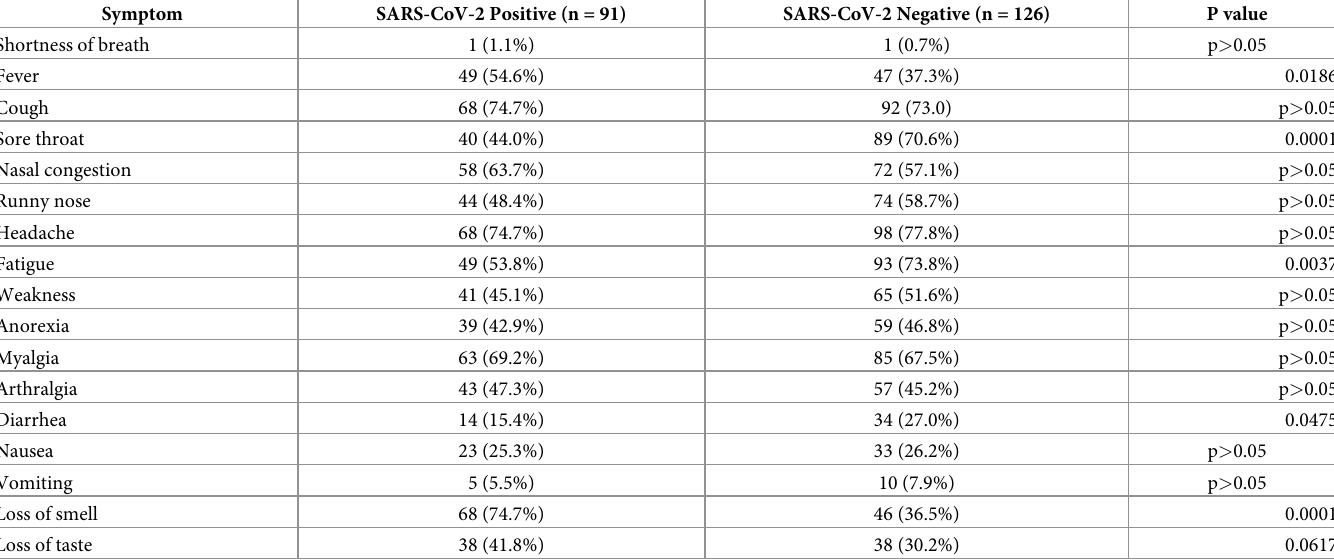
Table 2. Specific symptoms in individuals in association with nasopharynx SARS-CoV-2 status. Symptom